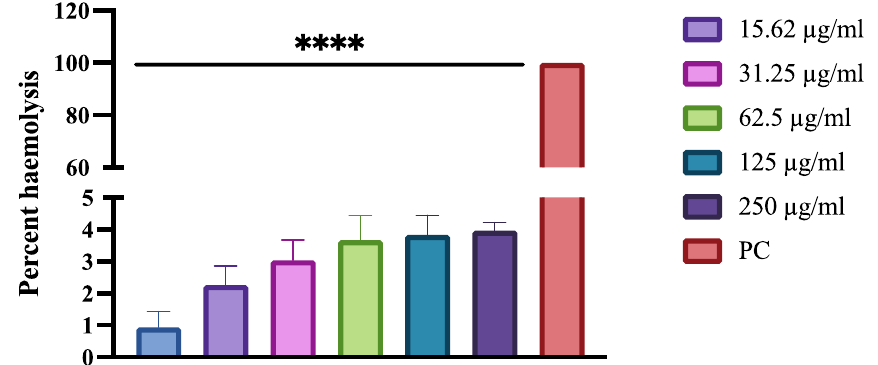
Figure 5. Percentage haemolysis of red blood cells following treatment with various concentrations of human neutrophile peptide. Hemolysis was calculated by an absorbance reading at 450 nm and compared to hemolysis achieved with 1% Triton X-100 (reference for 100% hemolysis). Bars with asterisks indicate significant differences as follows (**** p < 0.001).